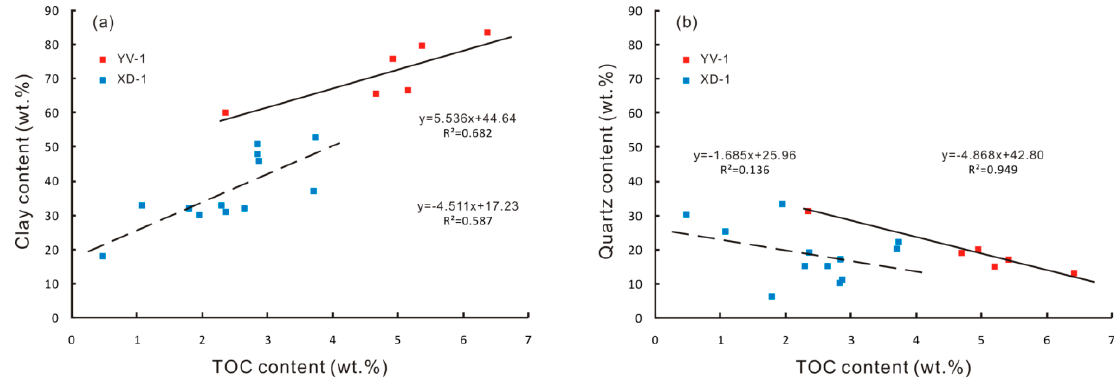
Figure 6. Relationships between TOC content and clay content ( a ), quartz content ( b ) of transitional Longtan Shale samples from YV-1 and XD-1.